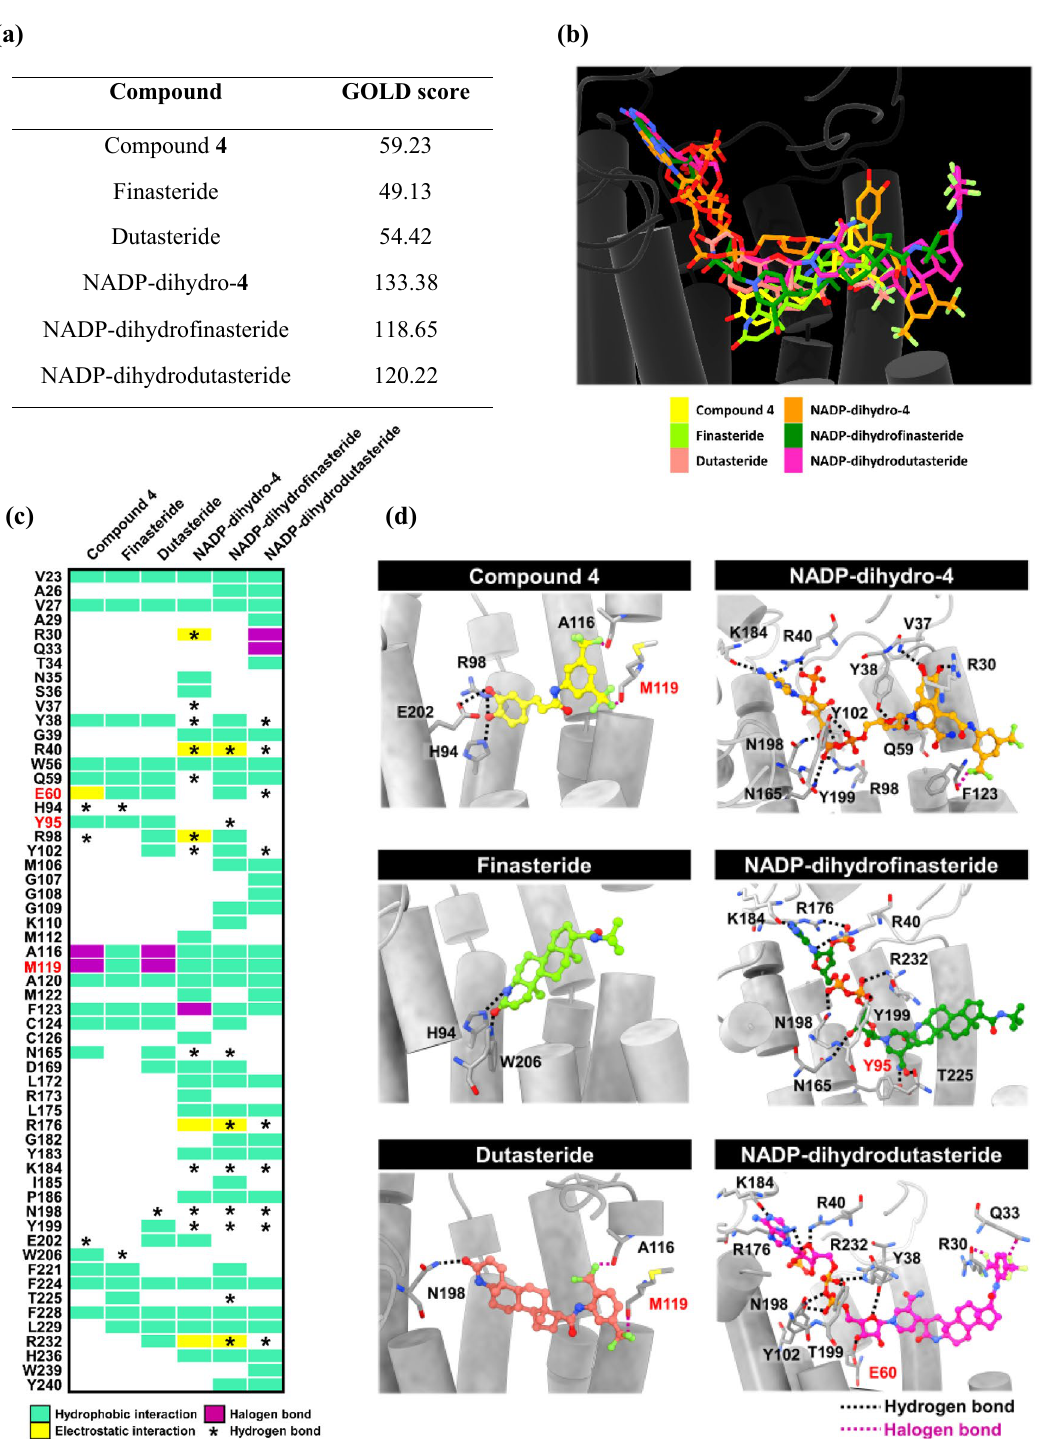
Figure 9. Binding interactions of the caffeic acid N -[3,5-bis(trifluoromethyl)phenyl] amide derivative (compound 4 ) and known inhibitors, finasteride and dutasteride with human SRD5A1 compared with their NADP adducts. ( a ) GOLD docking scores. ( b ) Superimposition of all the docked compounds. (c) The heat map of inhibitor-protein interaction is based on the default of the Discovery Studio Visualizer 2.5, which is determined according to the distance criteria of nonbonded interactions as follows: (1) hydrophobic interactions are derived from van der Waals fraction (≤ 0.70 Å), amide-π stacked (≤ 4.50 Å), alkyl (≤ 5.50 Å), π-alkyl (≤ 4.0 Å), π-sigma (≤ 4.0 Å) and π-π T-shaped (π-π centroid ≤ 6.0 Å); and (2) electrostatic interactions include π-anion (≤ 5.0 Å), π-cation (≤ 5.0 Å), salt bridge and attractive charge (≤ 5.6 Å). Additionally, the distances related to hydrogen bond (H-bond donor–-acceptor) and halogen bond (fluorine) are ≤ 3.40 Å and ≤ 3.70 Å, respectively. The red color texts represent the key catalytic residues. (d) The 3D geometry of all the docked compounds in the binding site with indicated hydrogen bond (black) and halogen bond (magenta)